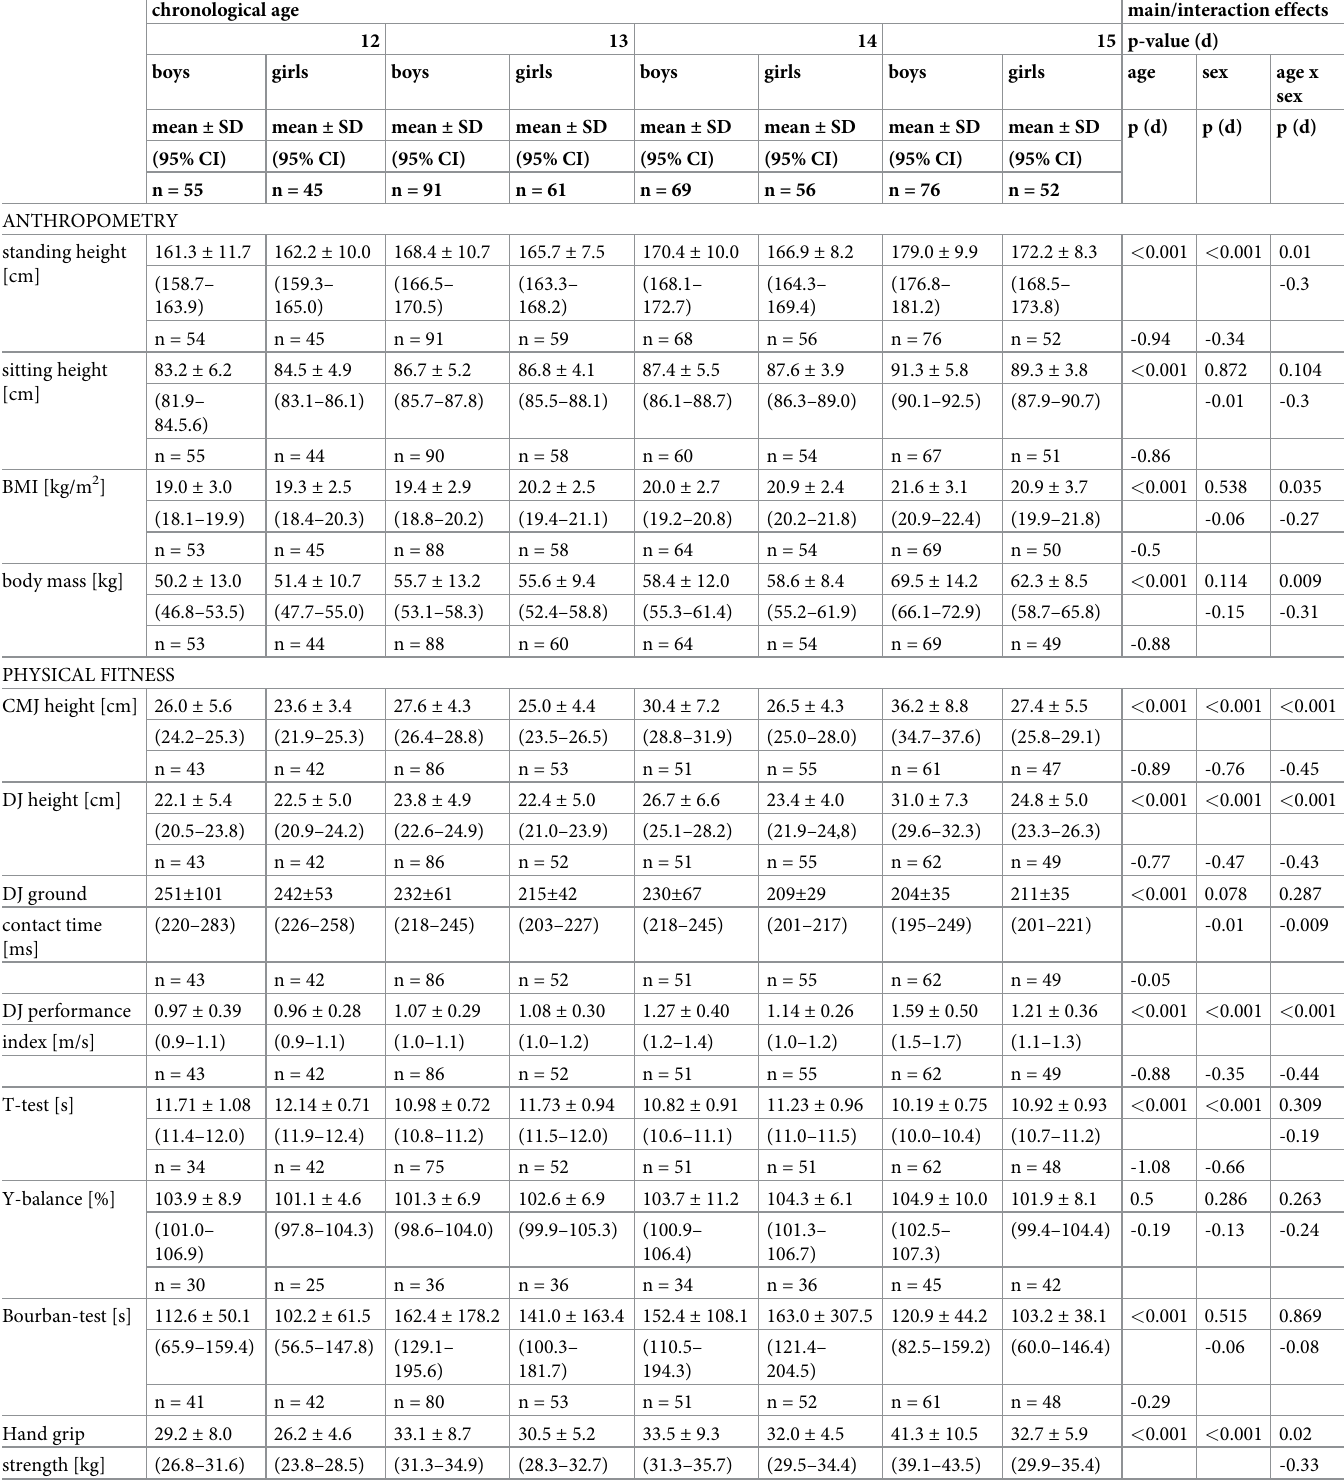
Table 1. Anthropometric and physical fitness differences according to chronological age and sex in young